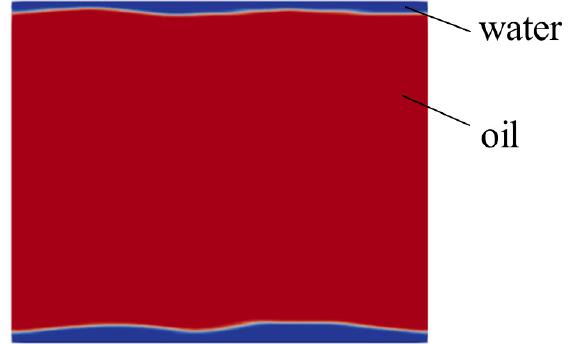
Figure 1. Principle of CAF [9]. (Red for oil and blue for water.)